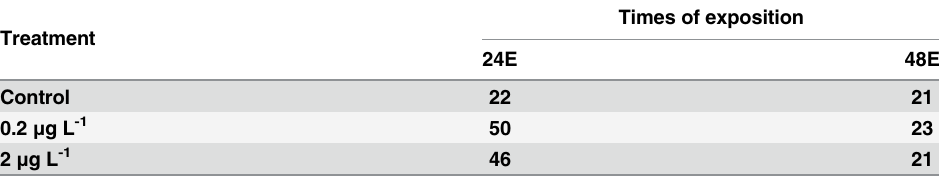
Table 1. Median fluorescence intensity (MFI) of erythrocytes marked by DHE.